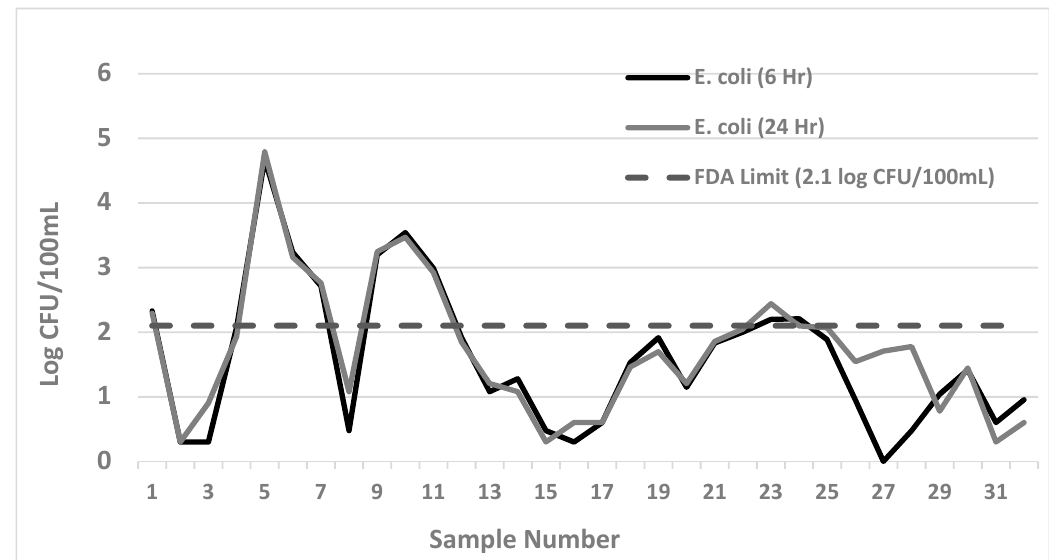
Figure 2. Generic Escherichia coli cell counts of 32 contaminated samples (69 samples tested at no detectable Escherichia coli ) at 6 h and 24 h sample holding time obtained from sixty Iowa produce farms in 2017–2018.